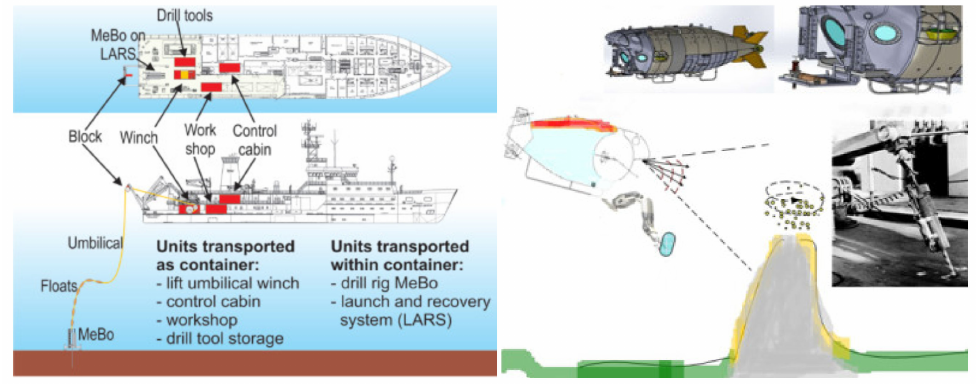
Figure 1. Deep sea drilling